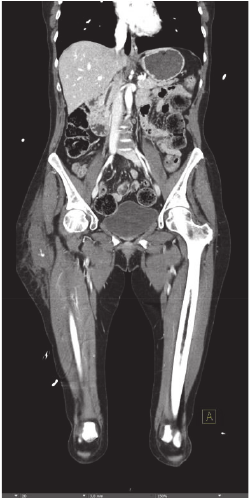
Figure 7: Coronal CT reconstructed images further detail the area of active extravasation and surrounding